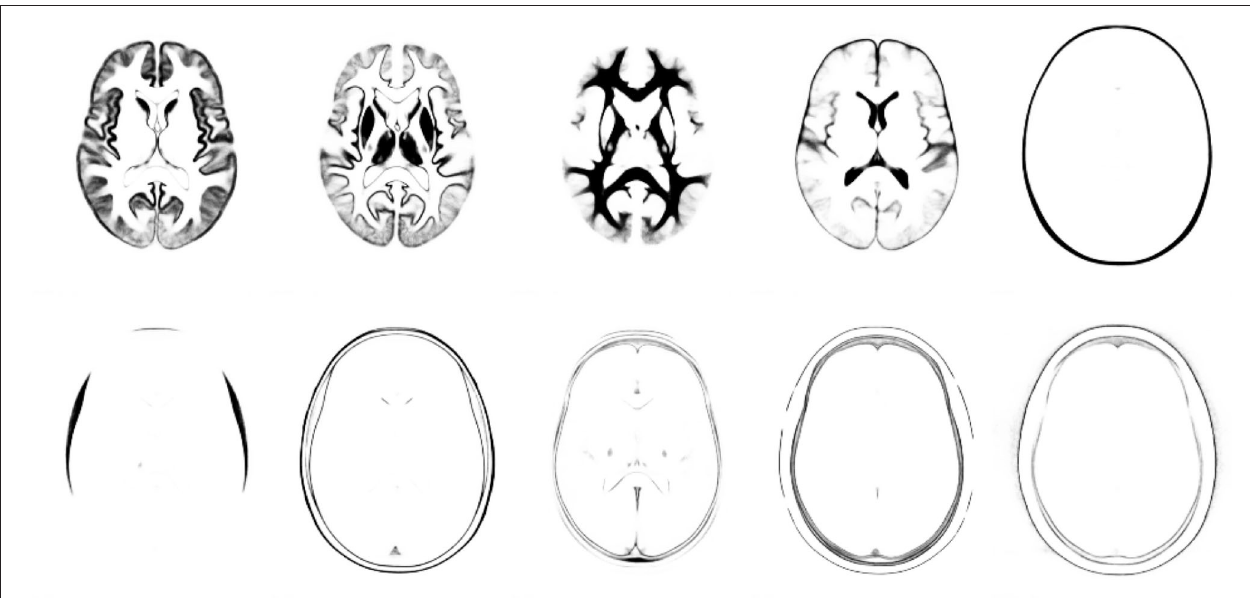
FIGURE 6 | Tissue priors used for diffeomorphic alignment and tissue classification (not showing the background class). The first three classes encode most of the tissues within the brain, and roughly encode pure grey matter, partial volume grey/white and pure white